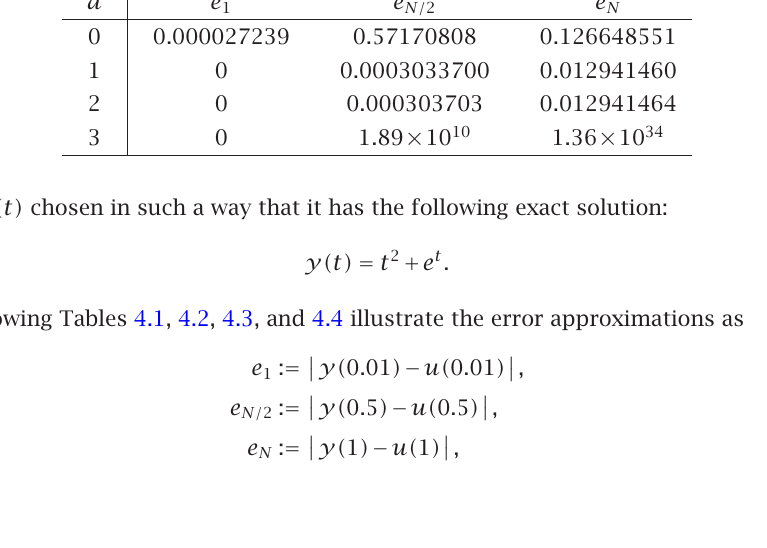
Table 4.4 . Approximate error when m = 3 and (Radau II parameters) ( { c